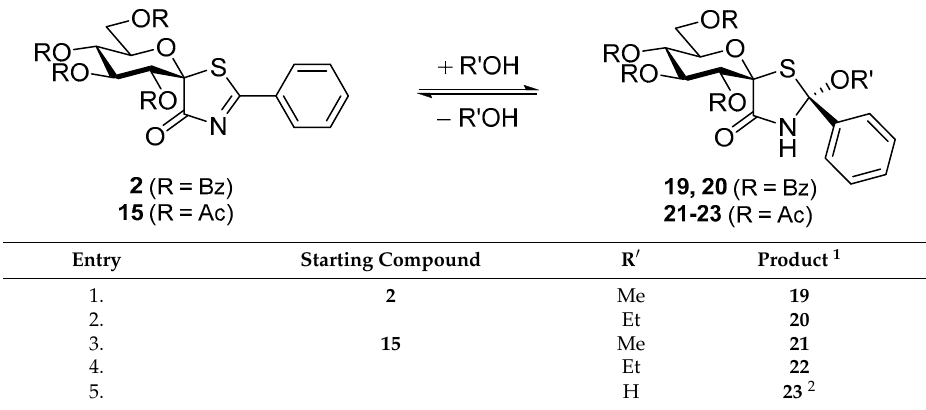
Table 3. Addition of alcohols and water onto spiro-thiazolinones 2 and 15 .